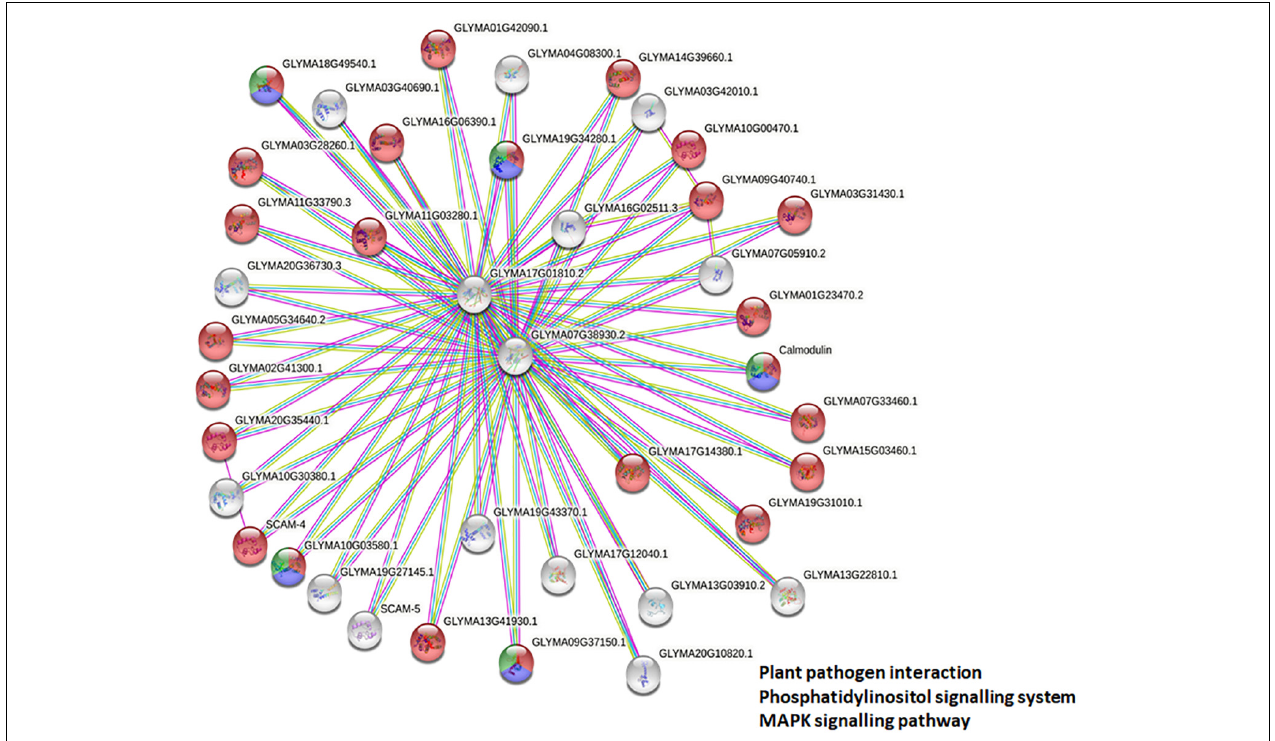
FIGURE 7 | Protein-protein interaction network analysis. Protein-protein interaction network and enrichment analysis showing the complex interplay among GmCMLs as predicted from the STRING database. The proteins colored in red are showing their potential involvement in plant-pathogen interaction, the proteins in blue color are predicted to be involved in phosphatidylinositol signaling, and the proteins in green color are predicted to be involved in MAPK signaling